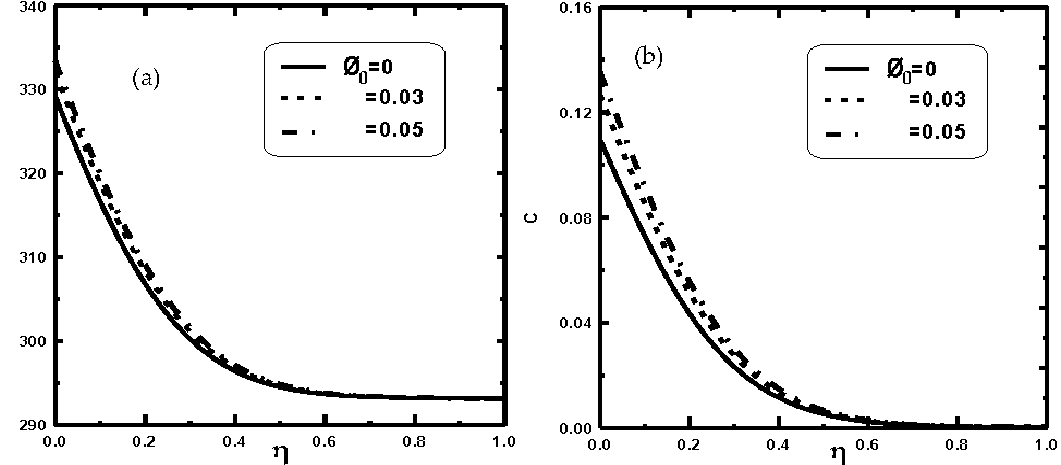
Figure 7. Effect of nanoparticle volume fraction on the temperature ( a ) and the vapor concentration ( b ) at the channel exit: T 0L = 293.15 K, T 0 = 293.15 K, q 1 = 3000 W/m 2 , c 0 = 0, T w = 293.15 K, u 0 = 1 m/s, H = 1 m, d = 0.015 m, m 0L = 15 × 10 − 4 Kg/m.s , p 0 = 1 atm.